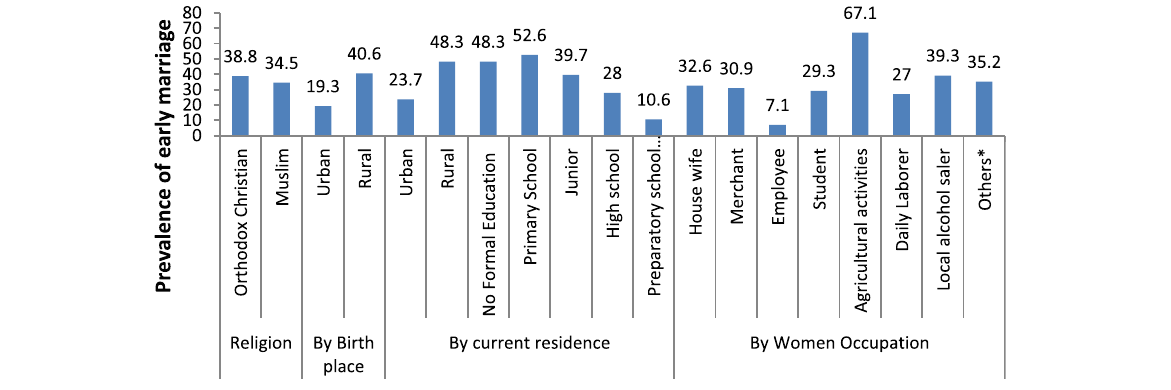
Fig. 2 Prevalence and profile of early marriage in Amhara National Regional State, Ethiopia (Survey,